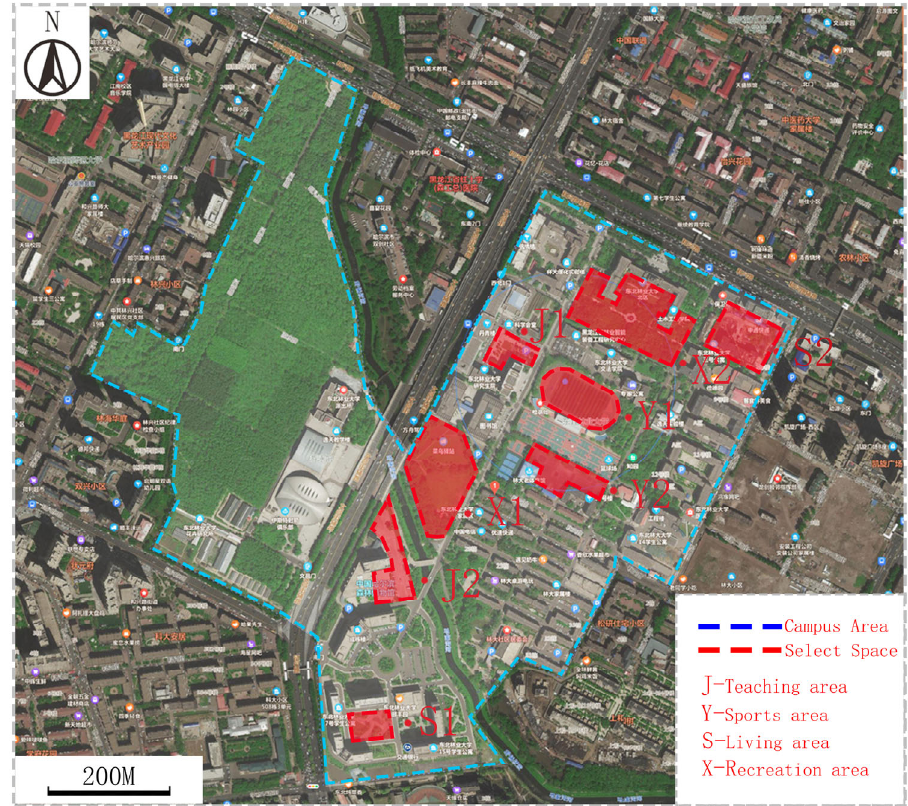
Figure 1. Diagram the selection of public space on campus. (Diagram: Sample spatial distribution map).